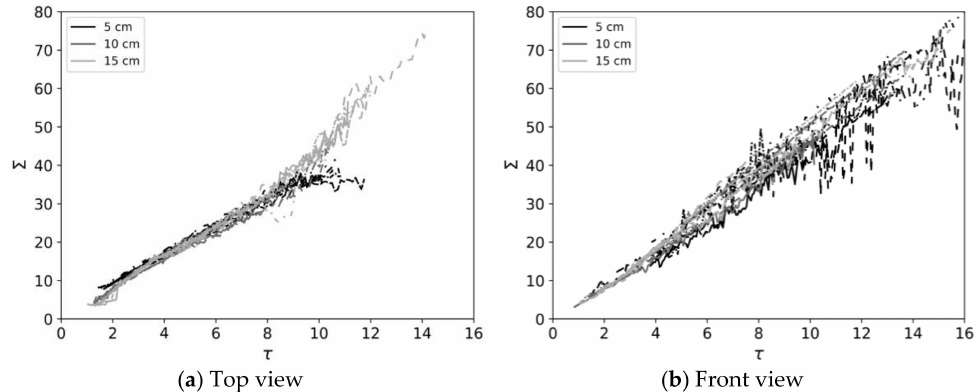
Figure 8. Temporal evolution of the cloud area (defined by Equation (21)) measured on the shadow- graphs in scaled coordinates.